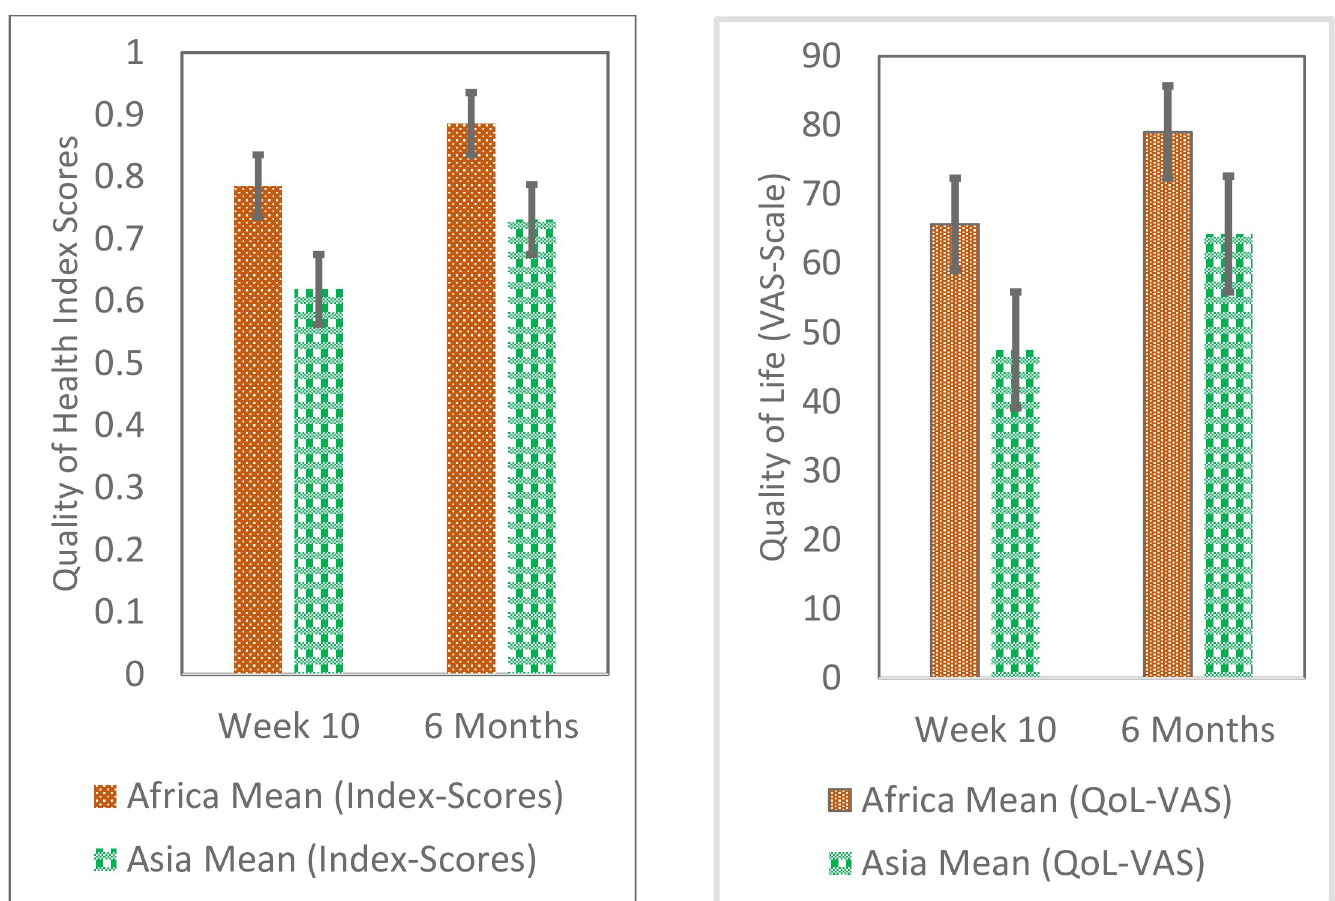
Fig 2. Mean VAS scores and Index scores at week 10 and 6 months after treatment initiation. Abbreviations: VAS, Visual analog scale; QoL, Quality of life.